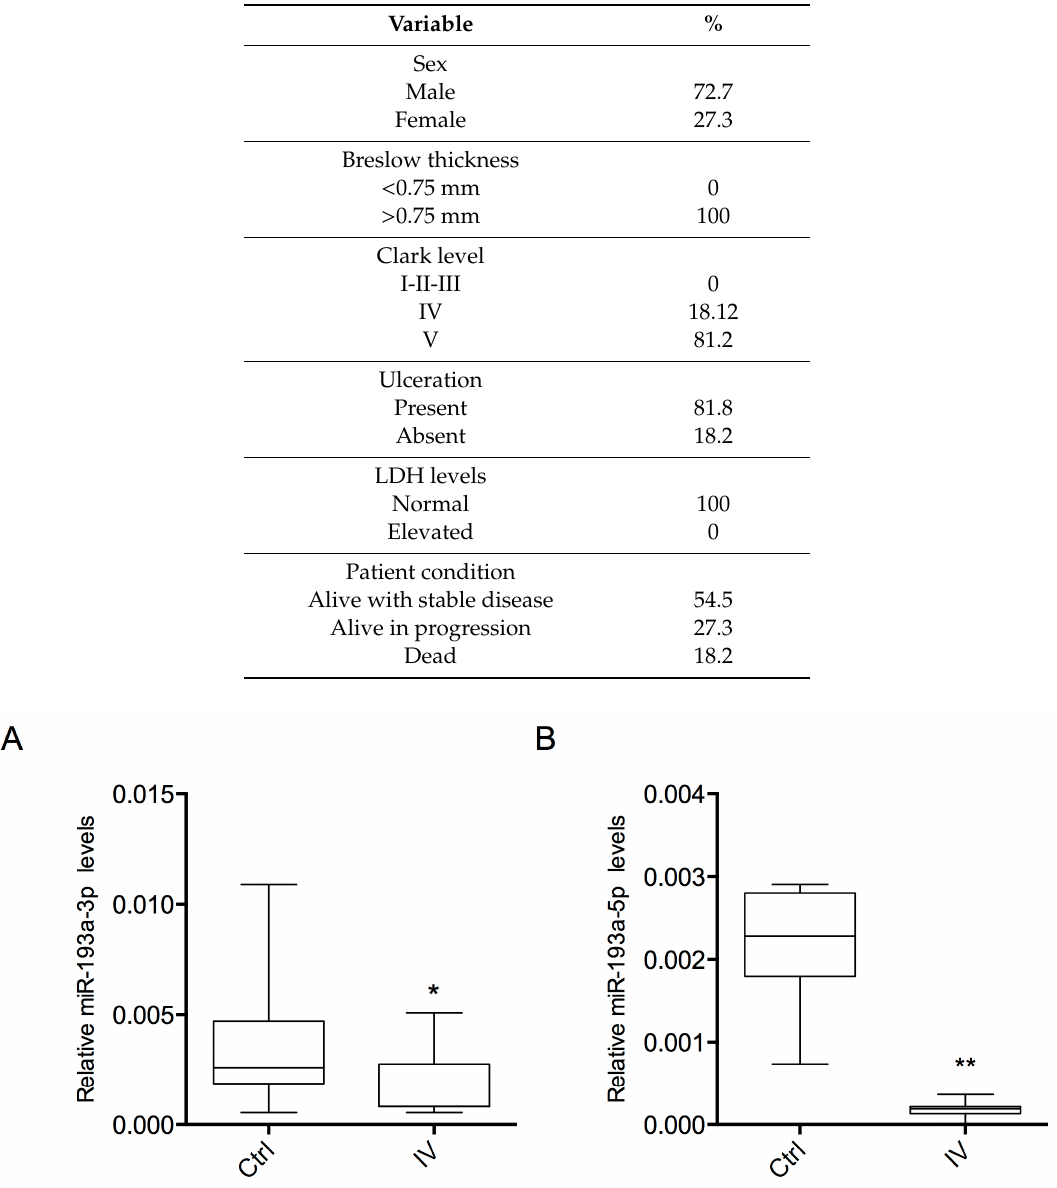
Figure 1. Expression levels of exosome-derived miR-193a in plasma samples. Relative expression of miR-193a-3p ( A ) and miR-193a-5p ( B ) in stage IV melanoma patients (IV) and healthy subjects (Ctrl). Statistical analysis was performed using Student’s t -test (* p < 0.05, ** p < 0.01).